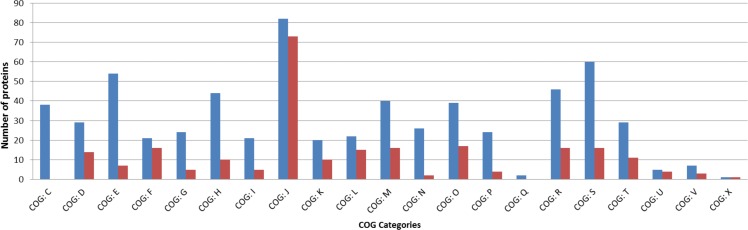
COG categories conserved across Bacillus probiotics vs. Lactobacillus probiotics.The orthologous proteins conserved across Bacillus probiotics and distribution of proteins in different COG categories are plotted in comparison to COG categories conserved across the Bacillus and Lactobacillus probiotics. X-axis represents the number of proteins and Y-axis represents the COG categories.